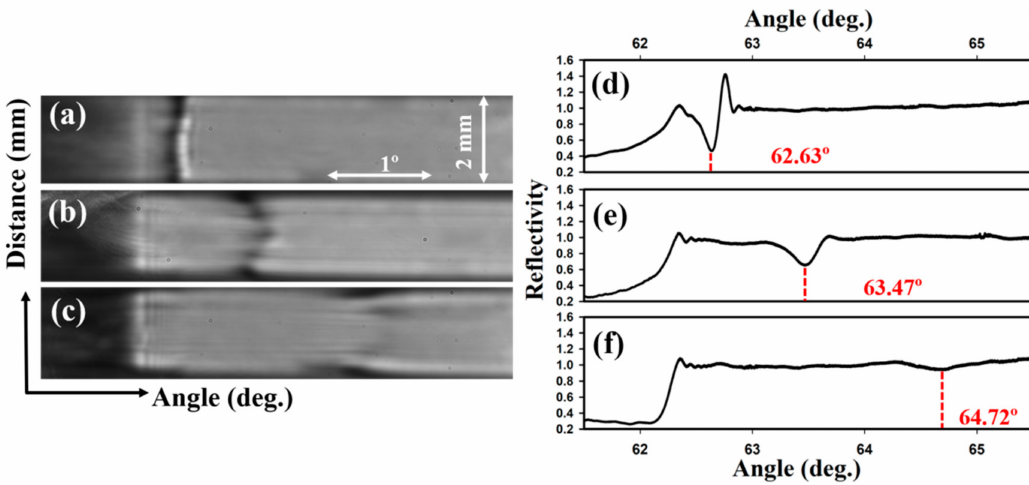
Figure 3. 2D and the corresponding 1D reflectivity of LWs after streptavidin immobilisation to chitosan films activated with ( a , d ) 0 mg / mL, ( b , e ) 1 mg / mL and ( c , f ) 2 mg / mL of PC-biotin (where angle is θ ext as marked in Figure